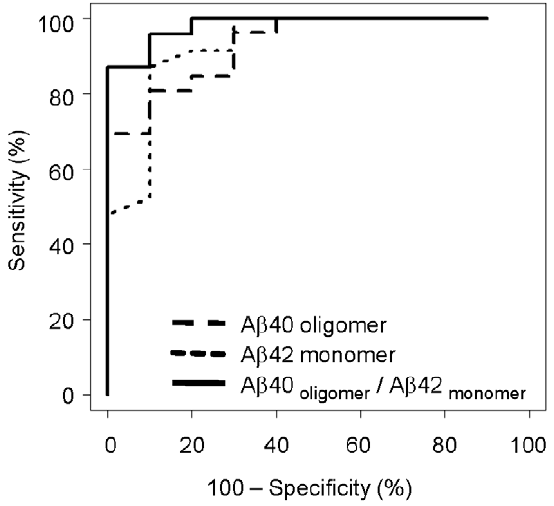
Figure 6. Receiver operating characteristic (ROC) curve. ROC analysis was performed to compare the diagnostic value of 3 biomarkers: oligomeric A b 40 (– –), monomeric A b 42 (- - -), and the ratio A b 40 oligomer /A b 42 monomer (––).